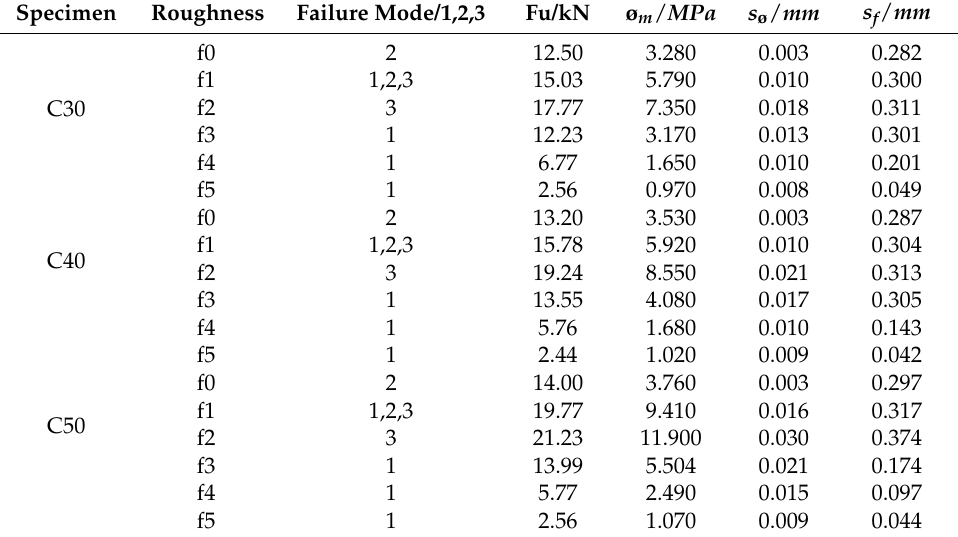
Table 4. Single shear test